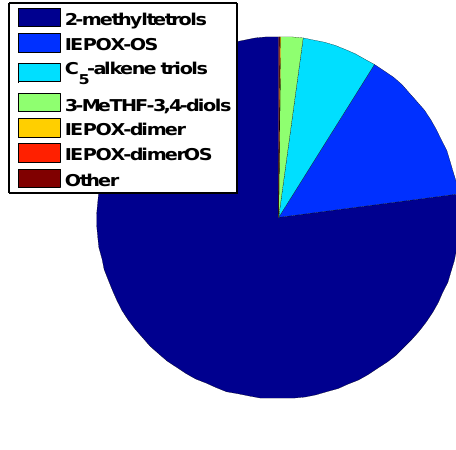
Figure 5. Model-predicted IEPOX-SOA tracer distribution and loadings for atmospherically relevant initial